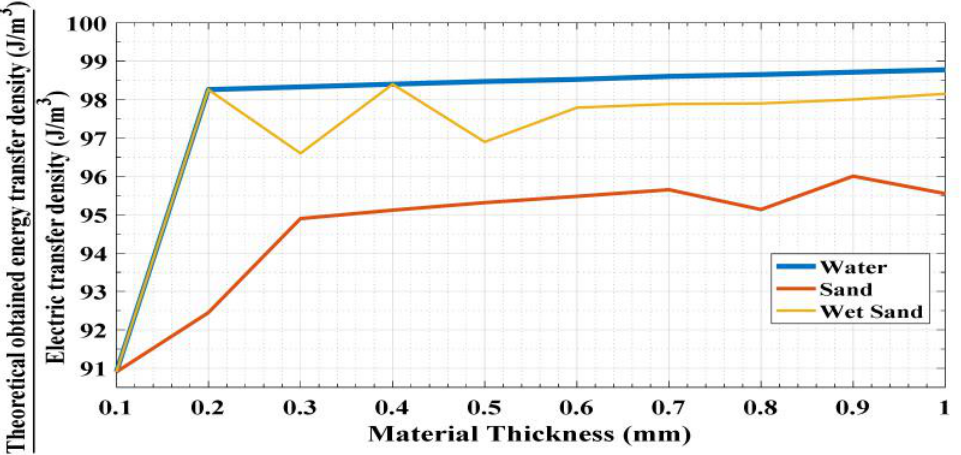
Figure 23. Variation of ratio of theoretical obtained energy transfer density to the electric transfer density with respect to material thickness.